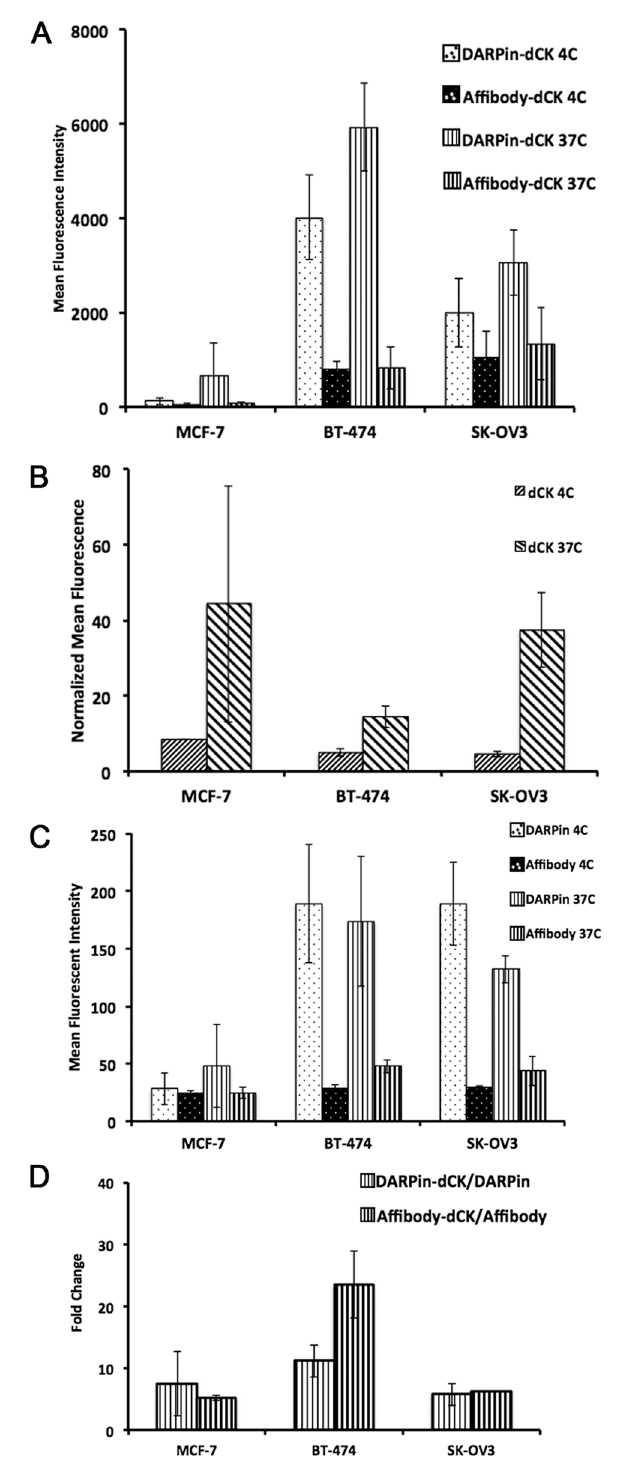
Fig 4. Binding of the bi-modular fusion proteins to cancer cells measured by flow cytometry. (A) One million cells were treatedwith 1 μ M of reagents as in Fig 2 and mean fluorescence intensity was measured using a Cyan3 fluorescent cell sorter (Beckman). Fluorescent cells were gated on cells treated with reagents that were not conjugated to dye and hence did not exhibit any fluorescence at 647 nm. Error bars correspond to standard deviations on three independent trials. (B) One million cells were treated with 1 μ M dCK-AlexaFluor ™ 647